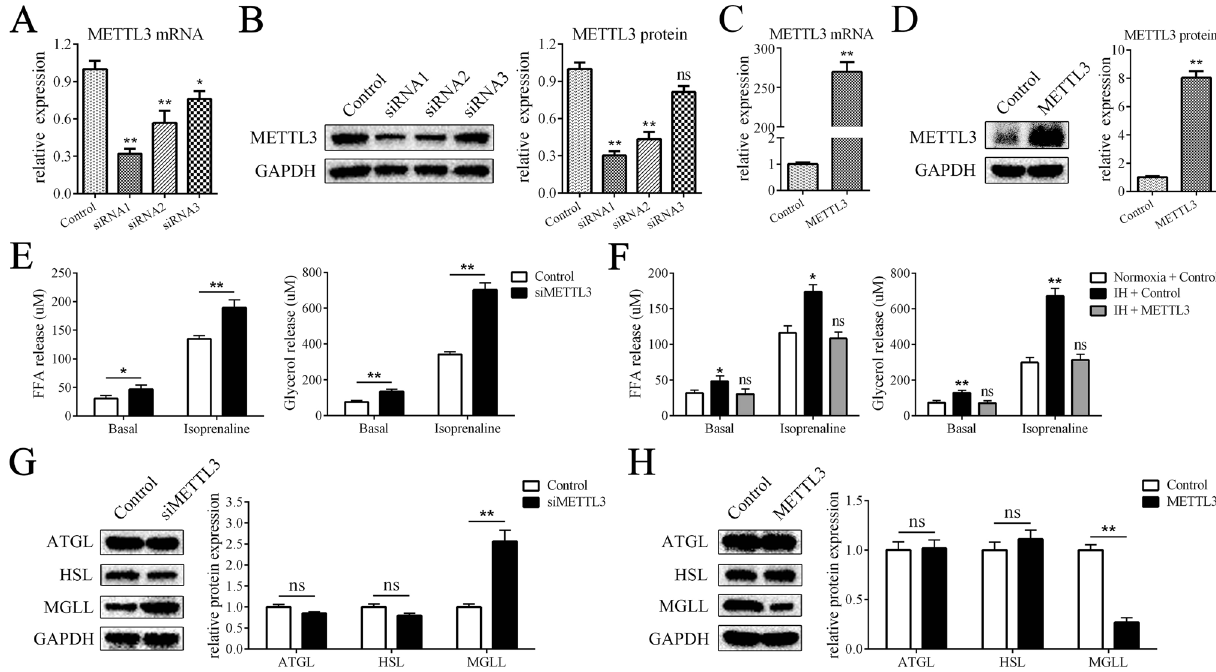
Fig. 3 METTL3 inhibits lipolysis in adipocytes. A , B The mRNA and protein levels of METTL3 in adipocytes transfected with siRNAs. C , D The mRNA and protein levels of METTL3 in adipocytes transfected with control lentivirus or METTL3 lentivirus. E METTL3 downregulation increased the levels of FFA release and glycerol release. F IH stimulation increased the levels of FFA release and glycerol release and overexpression of METTL3 rescued these effects. G METTL3 downregulation increased the protein levels of MGLL but not ATGL or HSL. H METTL3 overexpression reduced the protein levels of MGLL but not ATGL or HSL; n = 9, * P < 0.05, ** P < 0.01, ns indicates not signi fi cant. Control means treatment of negative control siRNA in A , B , E , G and means treatment of negative control lentivirus in C , D , F , H